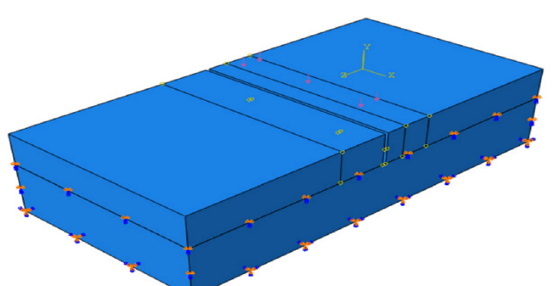
Fig. 15. The Boundary Condition of ABUQUS Models .